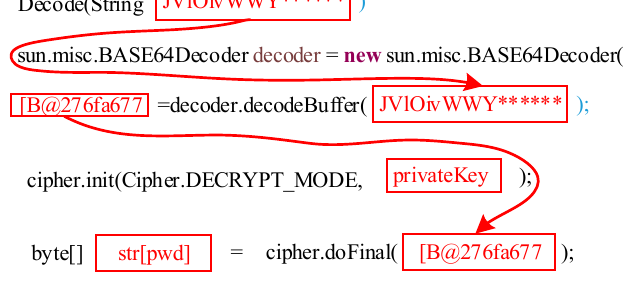
Table 2. Results for security analysis of Tencent QQ mail system version 2017 and RSAAuth.